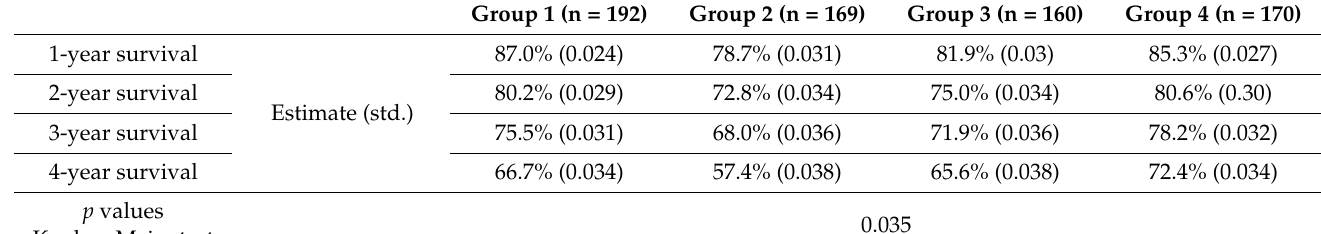
Table 3. The cumulative survival proportion according to the duration of invasive mechanical ventilation.